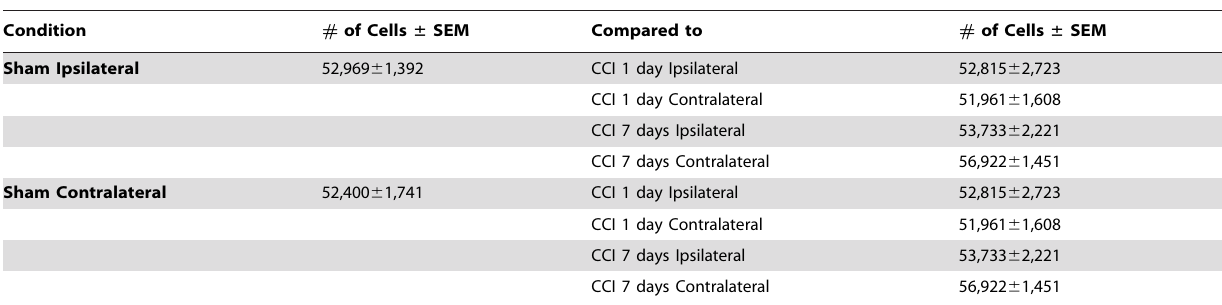
Table 1. Total Number of Neurons.